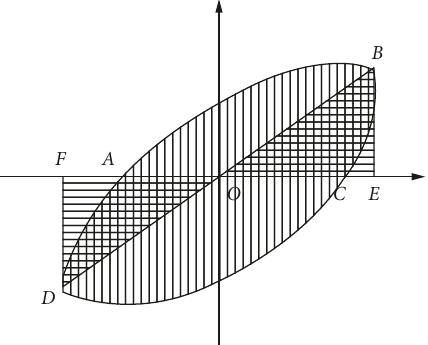
Figure 13: Equivalent viscous damping coefficient